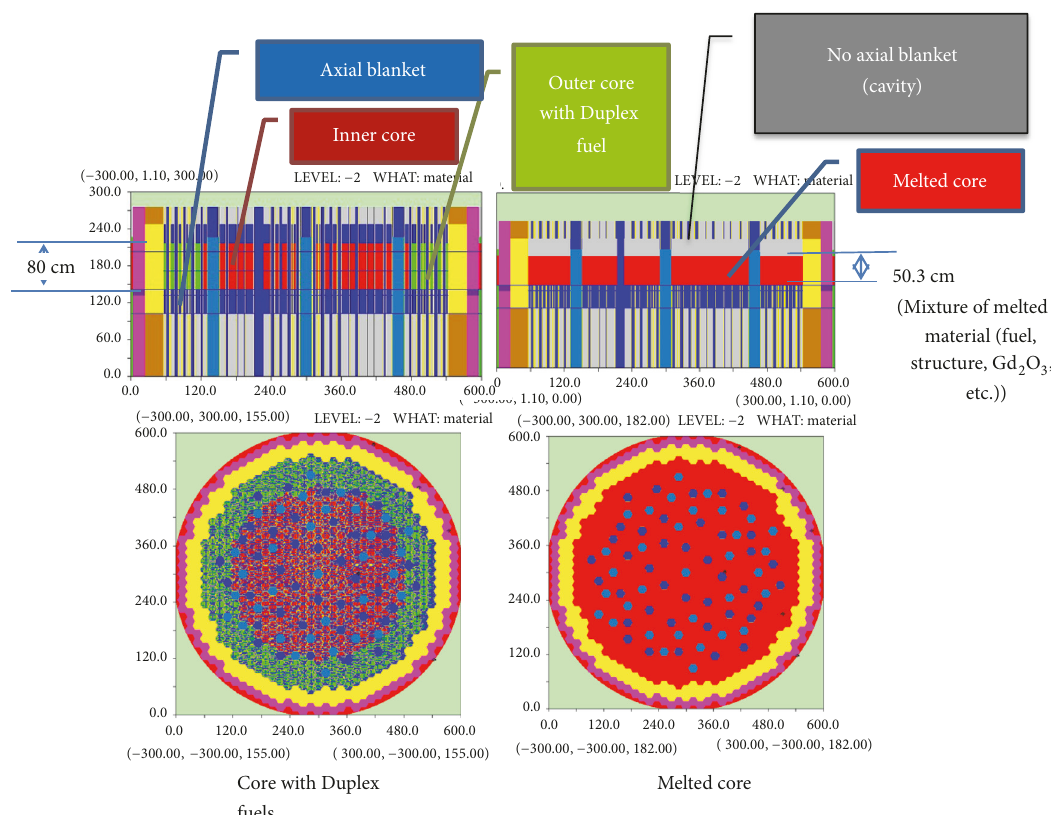
Figure 3: MVP calculation model of the core having Duplex pellets with neutron absorber and the melted core. The vertical and horizontal cross-sections of the two